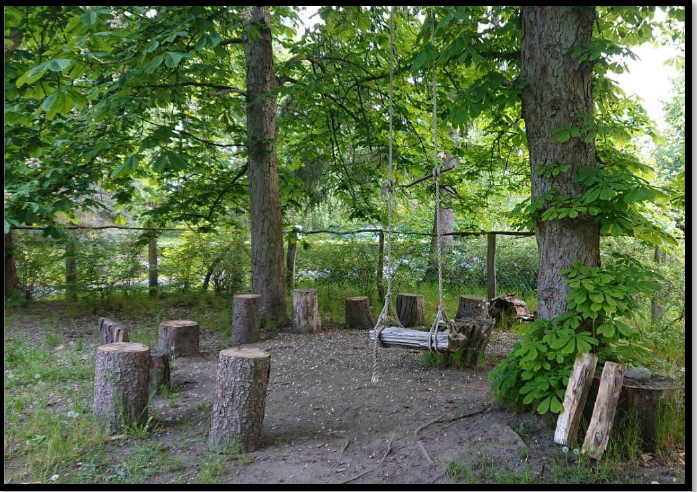
Figure 2. The circle of logs where each nature-based therapy session starts is in the back of the garden. Image by: Lilly Joschko © .